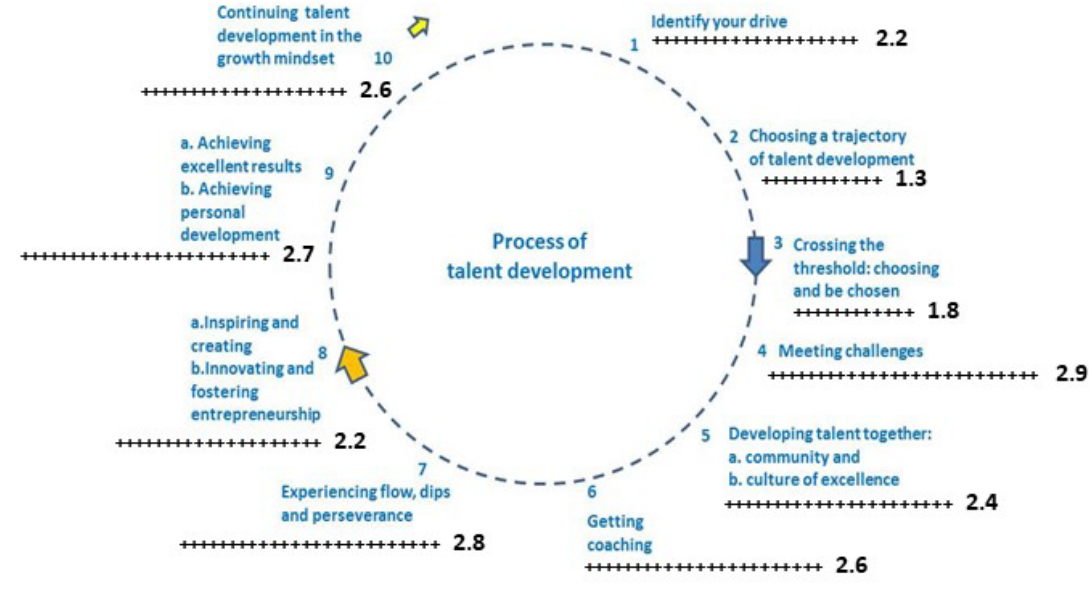
Figure 2: Circle of Talent Development with total scores of the nine good practices related to each step: total number of ‘+’ and the average